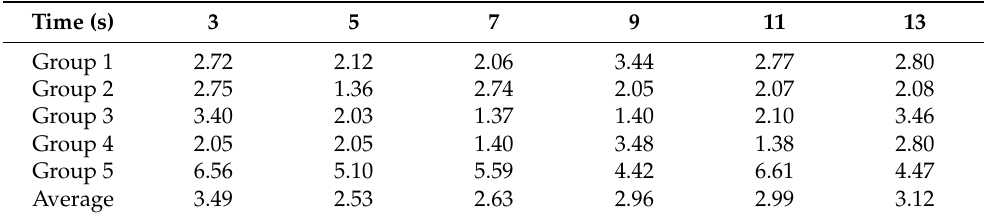
Table 3. Running time of the proposed method obtained by different dimensional